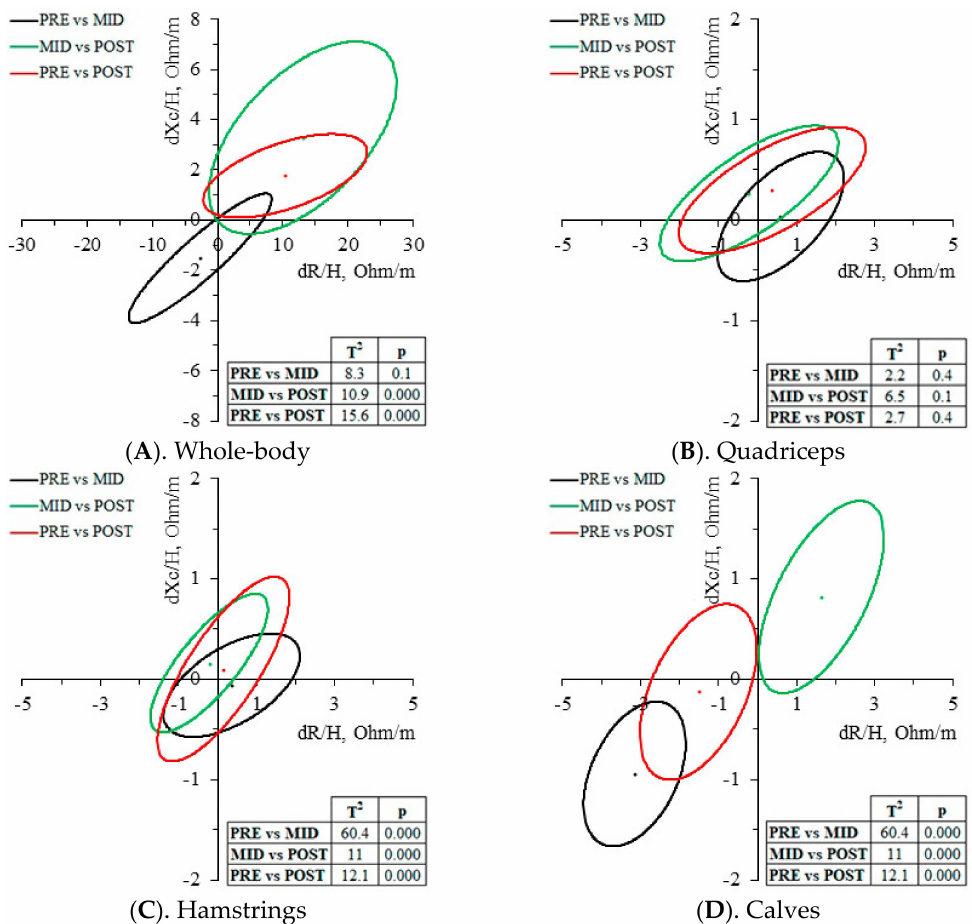
Figure 3. BIVA paired graph. Vector migration across the race. PRE, first assessment at the beginning of the race; MID, second assessment at the middle of the race; POST, last assessment at the end of the race; dR/H, height-adjusted resistance differences; dXc/H, height-adjusted reactance differences. T 2 , Hotelling’s T-squared distribution; p statistical significance, p <